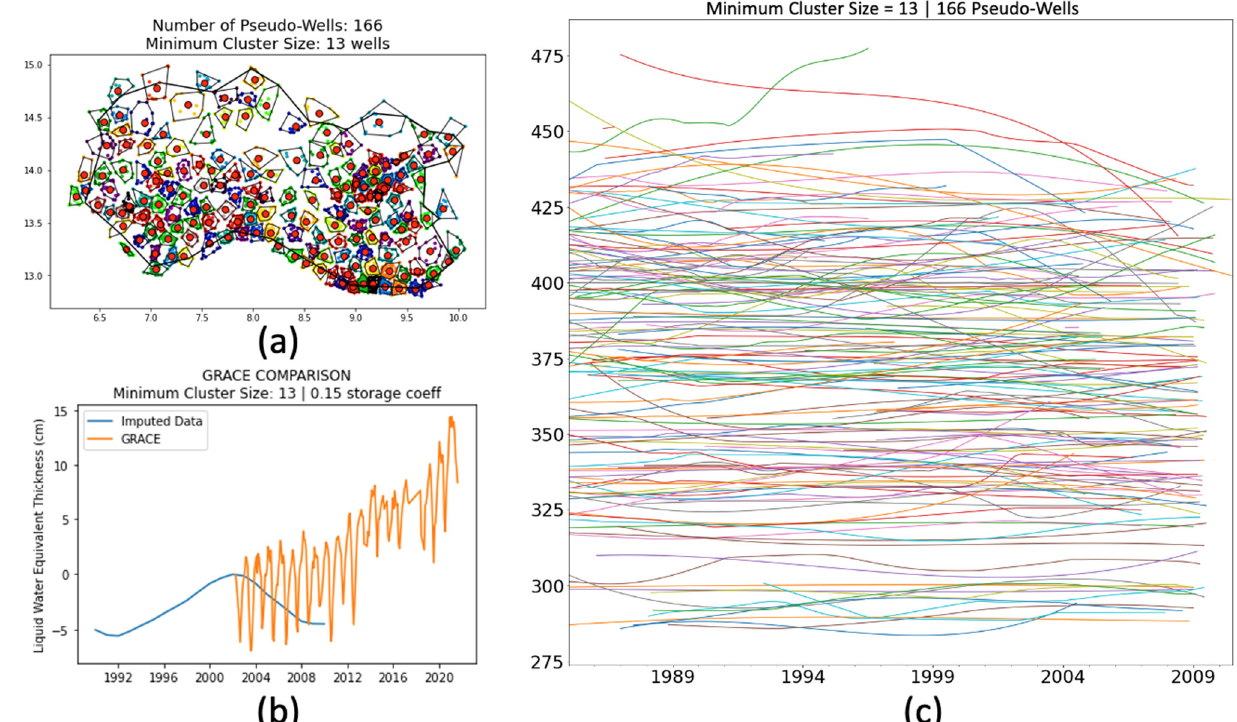
Figure 14. Using the k-means-constrained clustering with 13 minimum cluster size, ( a ) spatial distribution of the pseudo-wells, ( b ) groundwater storage change comparison against GRACE GWSa, and ( c ) synthetic WTE time series of each pseudo-well.